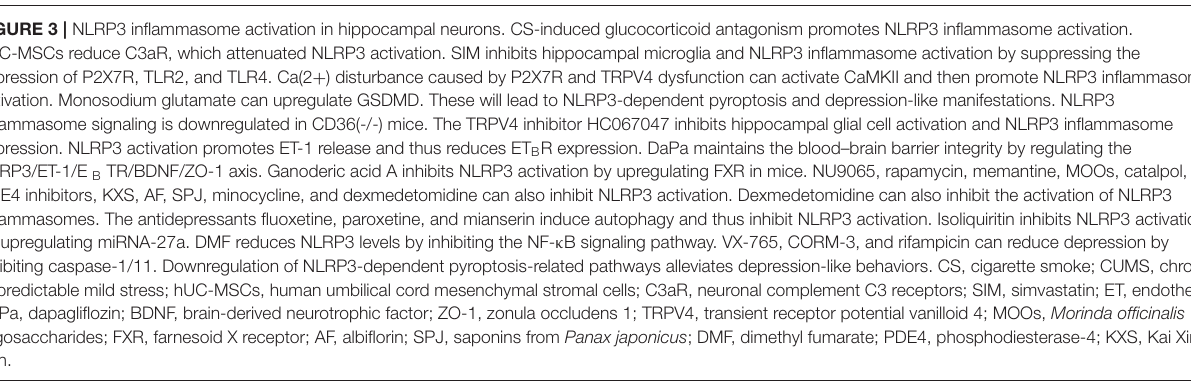
FIGURE 3 | NLRP3 inflammasome activation in hippocampal neurons. CS-induced glucocorticoid antagonism promotes NLRP3 inflammasome activation. hUC-MSCs reduce C3aR, which attenuated NLRP3 activation. SIM inhibits hippocampal microglia and NLRP3 inflammasome activation by suppressing the expression of P2X7R, TLR2, and TLR4. Ca(2 + ) disturbance caused by P2X7R and TRPV4 dysfunction can activate CaMKII and then promote NLRP3 inflammasome activation. Monosodium glutamate can upregulate GSDMD. These will lead to NLRP3-dependent pyroptosis and depression-like manifestations. NLRP3 inflammasome signaling is downregulated in CD36(-/-) mice. The TRPV4 inhibitor HC067047 inhibits hippocampal glial cell activation and NLRP3 inflammasome expression. NLRP3 activation promotes ET-1 release and thus reduces ET B R expression. DaPa maintains the blood–brain barrier integrity by regulating the NLRP3/ET-1/E B TR/BDNF/ZO-1 axis. Ganoderic acid A inhibits NLRP3 activation by upregulating FXR in mice. NU9065, rapamycin, memantine, MOOs, catalpol, PDE4 inhibitors, KXS, AF, SPJ, minocycline, and dexmedetomidine can also inhibit NLRP3 activation. Dexmedetomidine can also inhibit the activation of NLRP3 inflammasomes. The antidepressants fluoxetine, paroxetine, and mianserin induce autophagy and thus inhibit NLRP3 activation. Isoliquiritin inhibits NLRP3 activation by upregulating miRNA-27a. DMF reduces NLRP3 levels by inhibiting the NF- κ B signaling pathway. VX-765, CORM-3, and rifampicin can reduce depression by inhibiting caspase-1/11. Downregulation of NLRP3-dependent pyroptosis-related pathways alleviates depression-like behaviors. CS, cigarette smoke; CUMS, chronic unpredictable mild stress; hUC-MSCs, human umbilical cord mesenchymal stromal cells; C3aR, neuronal complement C3 receptors; SIM, simvastatin; ET, endothelin; DaPa, dapagliflozin; BDNF, brain-derived neurotrophic factor; ZO-1, zonula occludens 1; TRPV4, transient receptor potential vanilloid 4; MOOs, Morinda officinalis oligosaccharides; FXR, farnesoid X receptor; AF, albiflorin; SPJ, saponins from Panax japonicus ; DMF, dimethyl fumarate; PDE4, phosphodiesterase-4; KXS, Kai Xin